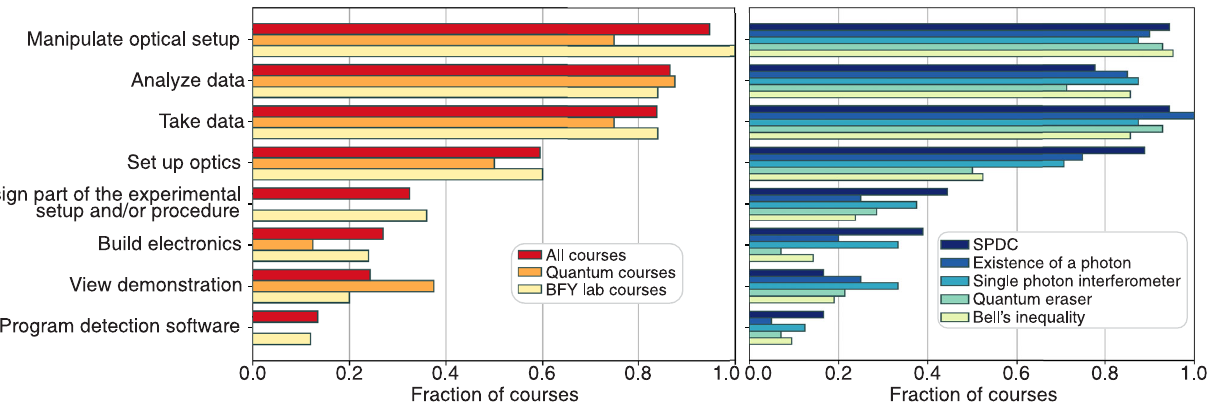
FIG. 3. Actions students performed. On the left is shown the fraction of all (red, N ¼ 37 ), quantum (orange, N ¼ 8 ), and BFY lab (yellow, N ¼ 25 ) courses in which students performed the specific action in at least one of the experiments. On the right, with the same vertical axis, is shown the fraction of courses that perform the experiments SPDC ( N ¼ 18 , darkest blue), existence of a photon ( N ¼ 20 ), single-photon interferometer ( N ¼ 24 ), quantum eraser ( N ¼ 14 ), and Bell ’ s inequality ( N ¼ 21 , lightest green) in which the students performed the specific